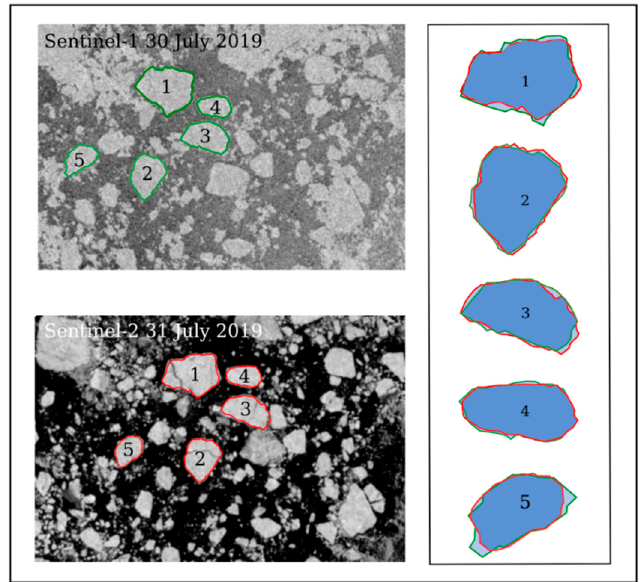
Figure 10. ( Left ): ice floe edges in a S-1 image (red) and in a S-2 image (green); ( Right ): dark blue is the intersection of the ice floes in the S-1 and S-2 images, light blue is their complement.